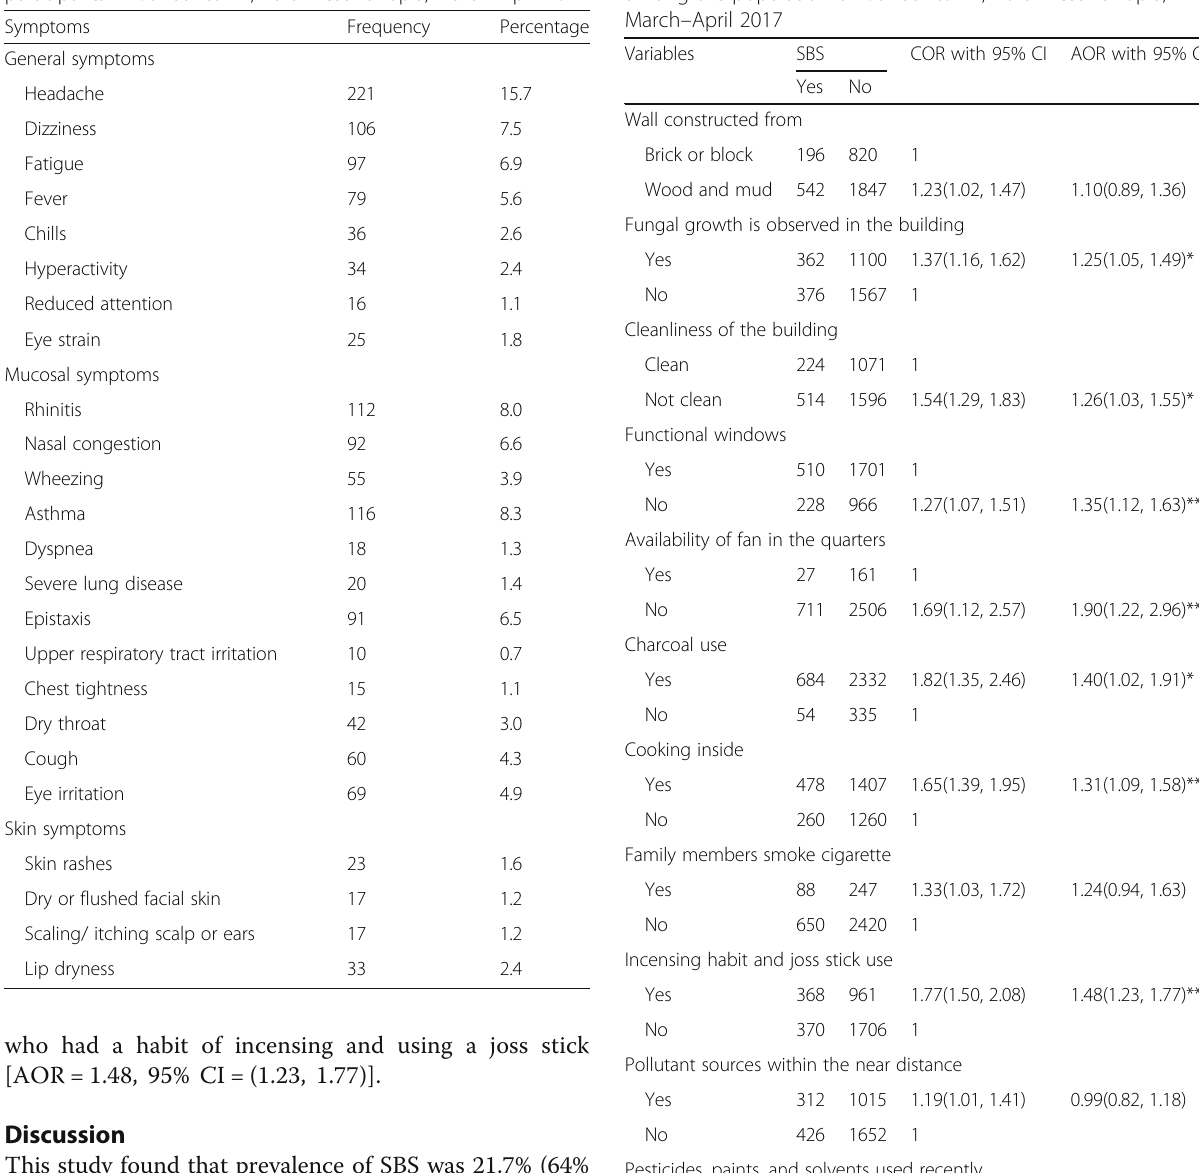
Table 4 Symptoms related with housing as reported by study participants in Gondar town, northwest Ethiopia, March – April 2017